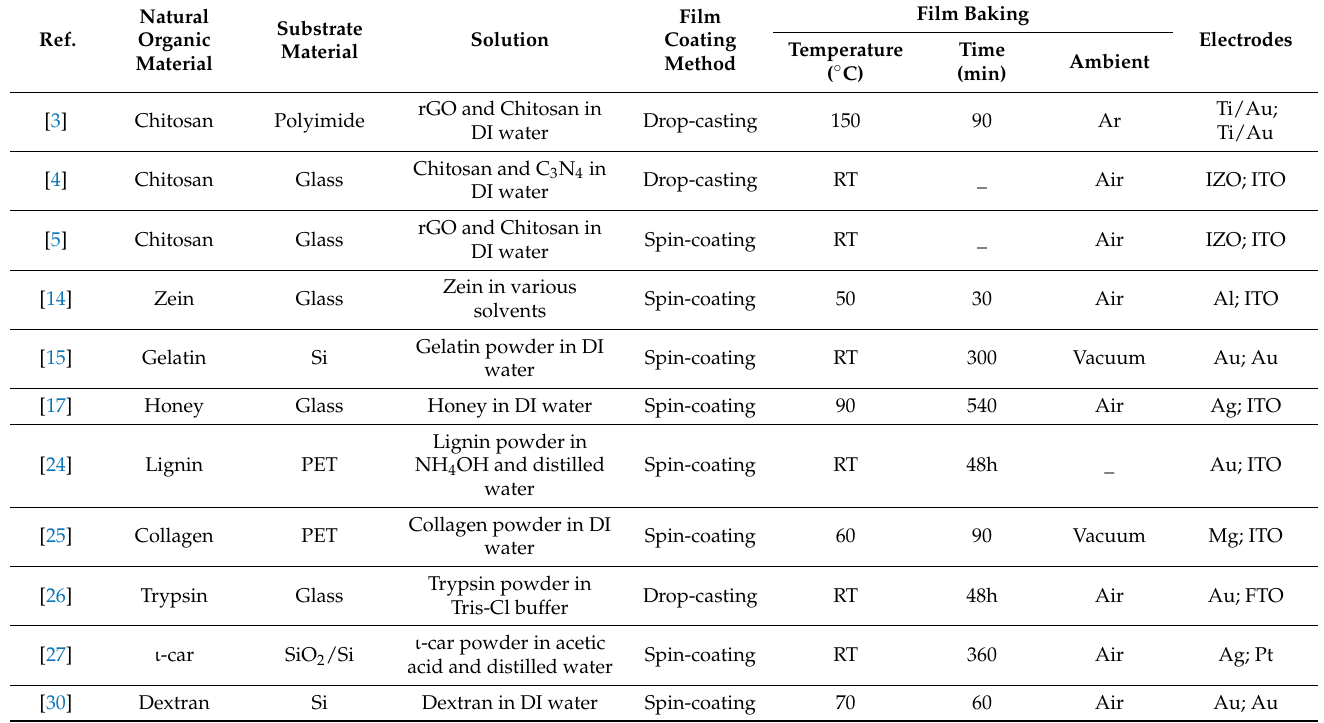
Table 1. Fabrication process of synaptic devices made from some representative natural organic